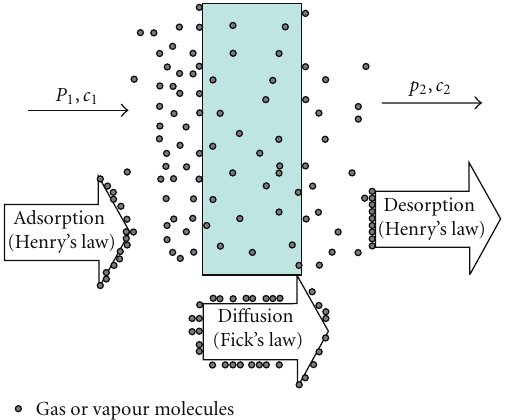
Figure 1: General mechanism of gas or vapour permeation through a plastic